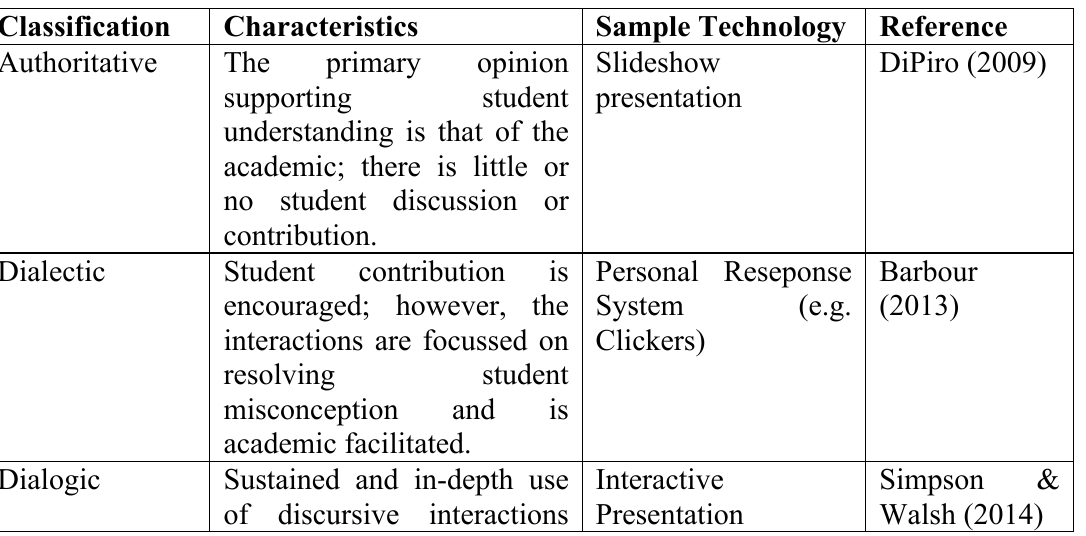
Table Two: Classification, and comparison, of the different levels of teaching enabled by technology with relevant technologies and sample case studies provided. Adapted from Beauchamp and Kennewell